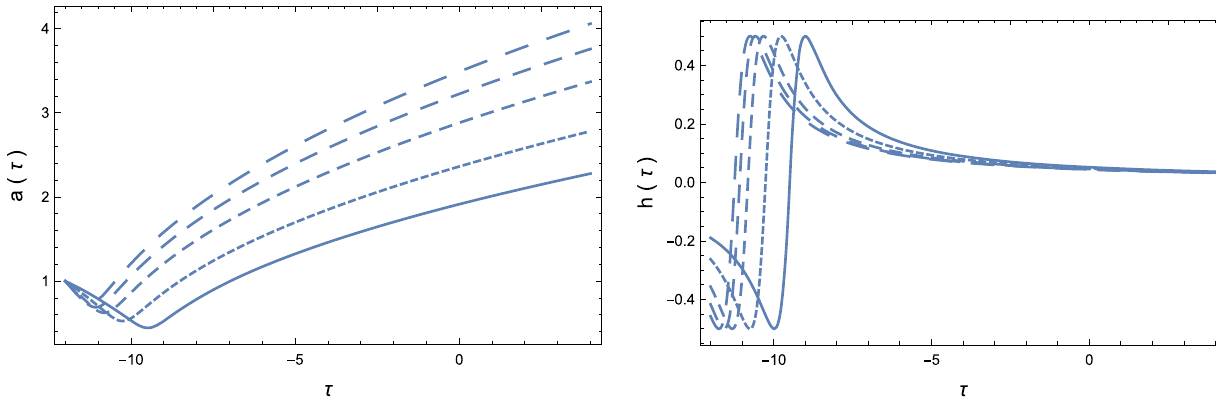
A 2 = 3 × 10 7 (short dashed curve), A 2 = 4 × 10 7 (dashed curve), and A 2 = 5 × 10 7 (long dashed curve), respectively. The initial conditions used to numerically integrate Eqs. (71) and (72) are θ (τ 0 ) = 0 . 009, while h 0 is obtained from Eq. (76)